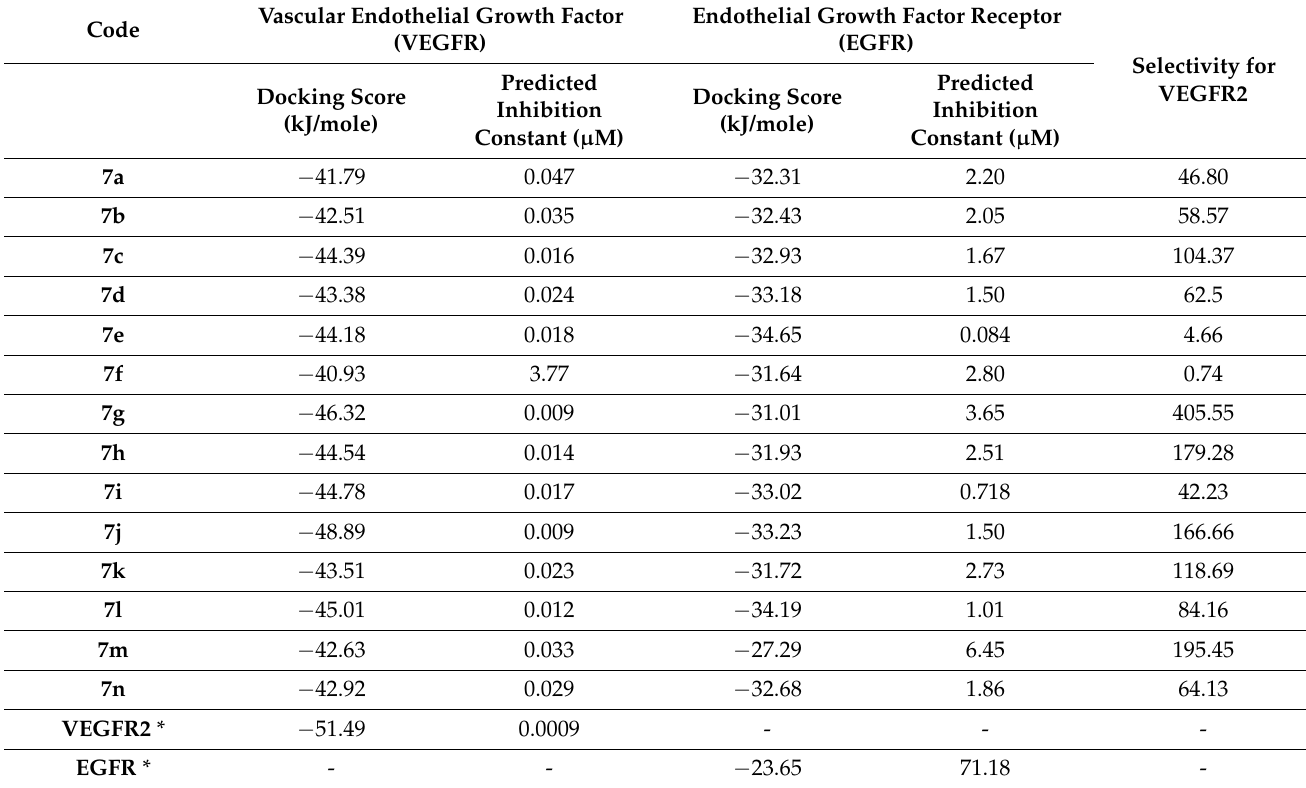
Table 4. Docking score of selected compounds by considering bound and unbound states of the ligand along with their predicted inhibition constant (pIC 50